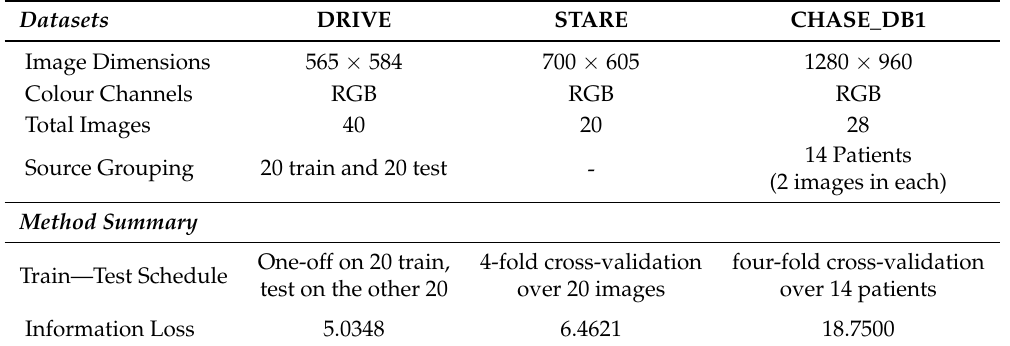
Table 2. Dataset